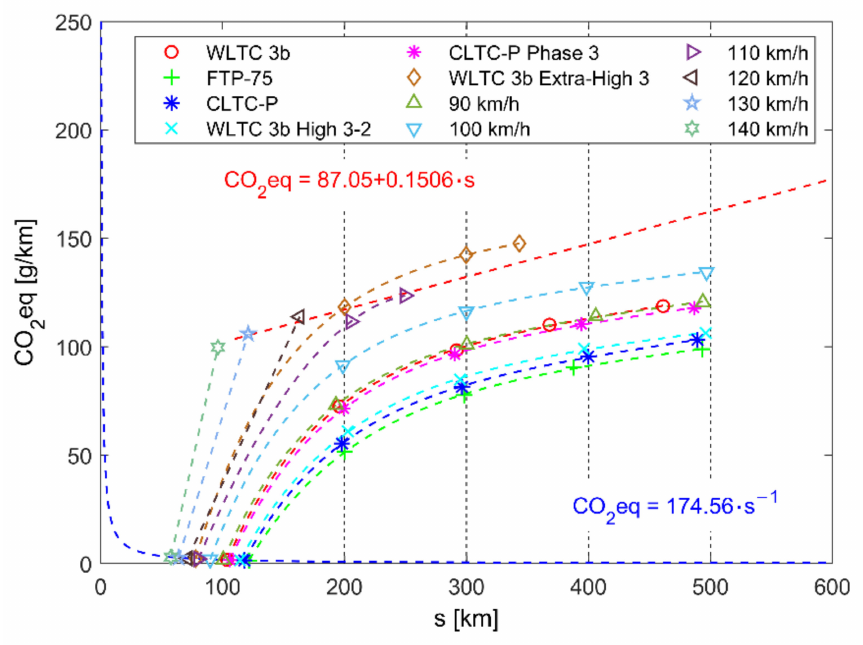
Figure A12. Combined CO 2 eq emission, due to EREV operation and electricity production (Sweden), in various driving conditions. Note that the blue approximation line (BEV mode) and the red approximation line (maximal range) are obtained for constant speed driving results from the range of 90–140 km/h. Vehicle mass is equal to 2100 kg.